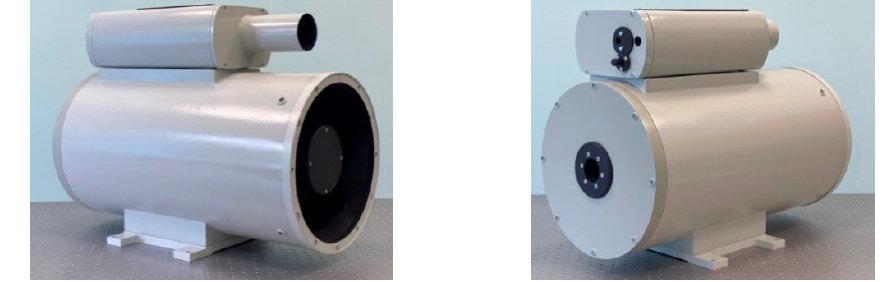
Figure 6. Split system (collimator–receiving telescope) of the mobile airborne lidar.